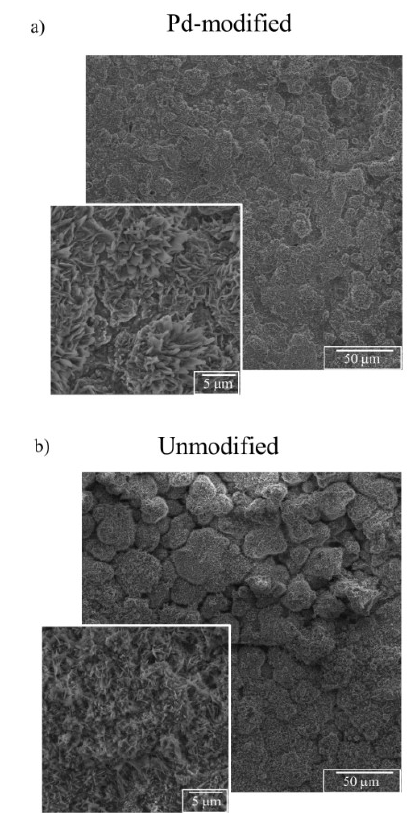
O scale at the surface of aluminized 2 3